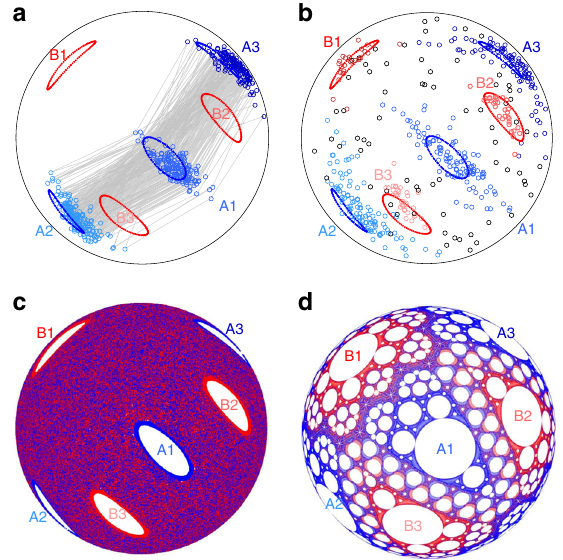
Fig. 2 Period-3 non-mixing regions under the (57°, 57°) protocol. a In one experiment, the tracer particle cycles between period-3 regions A1-A3 (blue circles) with stroboscopic paths (gray lines) for 500-iterations of the protocol. b In a second experiment with the same macroscopic initial conditions, the tracer particle cycles between period-3 regions A1-A3 (blue circles) for 326 iterations (1 – 90, 96 – 331), period-3 regions B1-B3 (red circles) for 101 iterations (386 – 486), and outside of period-3 regions (black circles) for 73 iterations (91 – 95, 332 – 385, and 487 – 500). c Passive tracers in the fi nite fl owing layer (FL) model mix everywhere except in two sets of period-3 regions (A1-A3 and B1-B3), whose boundaries are superimposed on the experimental data in a , b . d The piecewise isometry model (PWI), which describes solids mixing by cutting-and-shuf fl ing, predicts unmixed cells (white regions) of which only the largest cells, (A1-A3, B1-B3) persist in the FL model ( c ). Period-3 trapping regions from experiments correspond with period-3 cells from the FL and PWI models [blue (red) curves for regions A1-A3 (B1-B3)]. Bottom-views ( + y -direction) shown in all is the maximal dimensionless FL depth at the center of the sphere ( x = z = 0) for shear rate _ γ and angular rotation velocity ω . All variables are dimensionless — lengths are normalized by the tumbler radius R and the rotation period T is normalized by 1/ ω . This FL continuum model, which includes stretching characteristic of chaotic fl ows 3 , is parameterized by the FL depth ϵ , which is set to 0.15 to match the conditions in the experiments (Methods section).